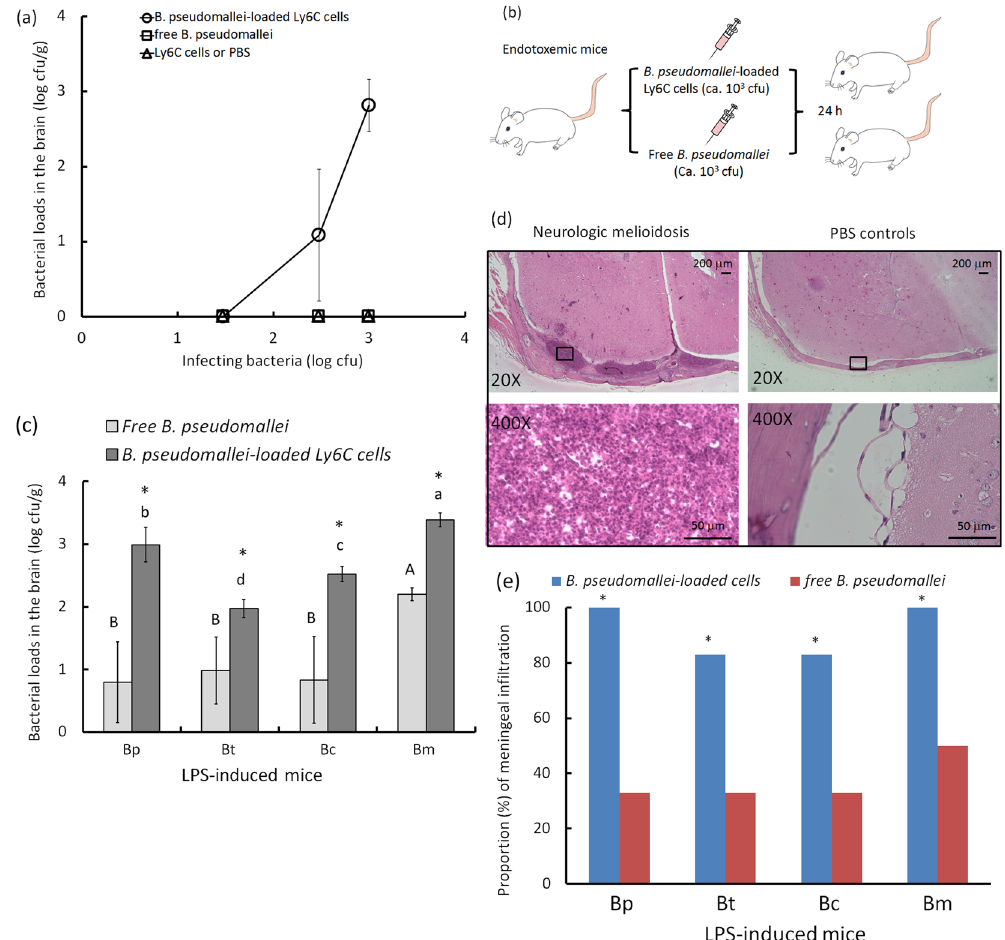
Figure 6. Bacterial loads in the brain and meningeal neutrophil infiltration. The dose-response curves for bacterial loads in the brain (CFU/g) were determined for the healthy mice that were adoptively transferred with B. pseudomallei -loaded Ly6C cells (2.5 × 10 2 cells, 30 CFU; 3.6 × 10 3 cells, 300 CFU; 4.2 × 10 4 cells, 1000 CFU) and free B. pseudomallei (30–1000 CFU). PBS or empty Ly6C cells were used as controls ( a ). To detect the bacterial loads in the brain in endotoxemic mice, the experimental design of neurologic melioidosis in endotoxemic mice is shown ( b ). After 24 h, the bacterial loads in the brain of the endotoxemic mice that were adoptively transferred with B. pseudomallei -loaded Ly6C cells (4.2 × 10 4 cells, 10 3 CFU) and free B. pseudomallei (10 3 CFU) are shown. The letters a-d or A-B represent significant differences at p < 0.05 (one- way ANOVA; Tukey’s HSD test). Asterix represent significant difference at p < 0.05 (t-test; comparison between B. pseudomallei -load cell group and free B. pseudomallei group in any of four endotoxemic groups) ( c ). After adoptive transfer, the representative tissues with meningeal neutrophil infiltration in the parietal lobes are shown ( d ): meningeal neutrophil infiltration, upper left, 100X and bottom left, 400X ; PBS-treated control, upper right, 100X and bottom right, 400X ). The proportions of brains showing meningeal neutrophil infiltration in the B. pseudomallei (Bp) LPS-, B. thailandensis (Bt) LPS-, B. cenocepacia (Bc) LPS- or B. multivorans (Bm) LPS-induced groups are shown ( e ). Asterix represent significant difference at p < 0.05 (Fisher’s exact test, one-tailed; comparison between B. pseudomallei -load cell group and free B. pseudomallei group in any of four endotoxemic